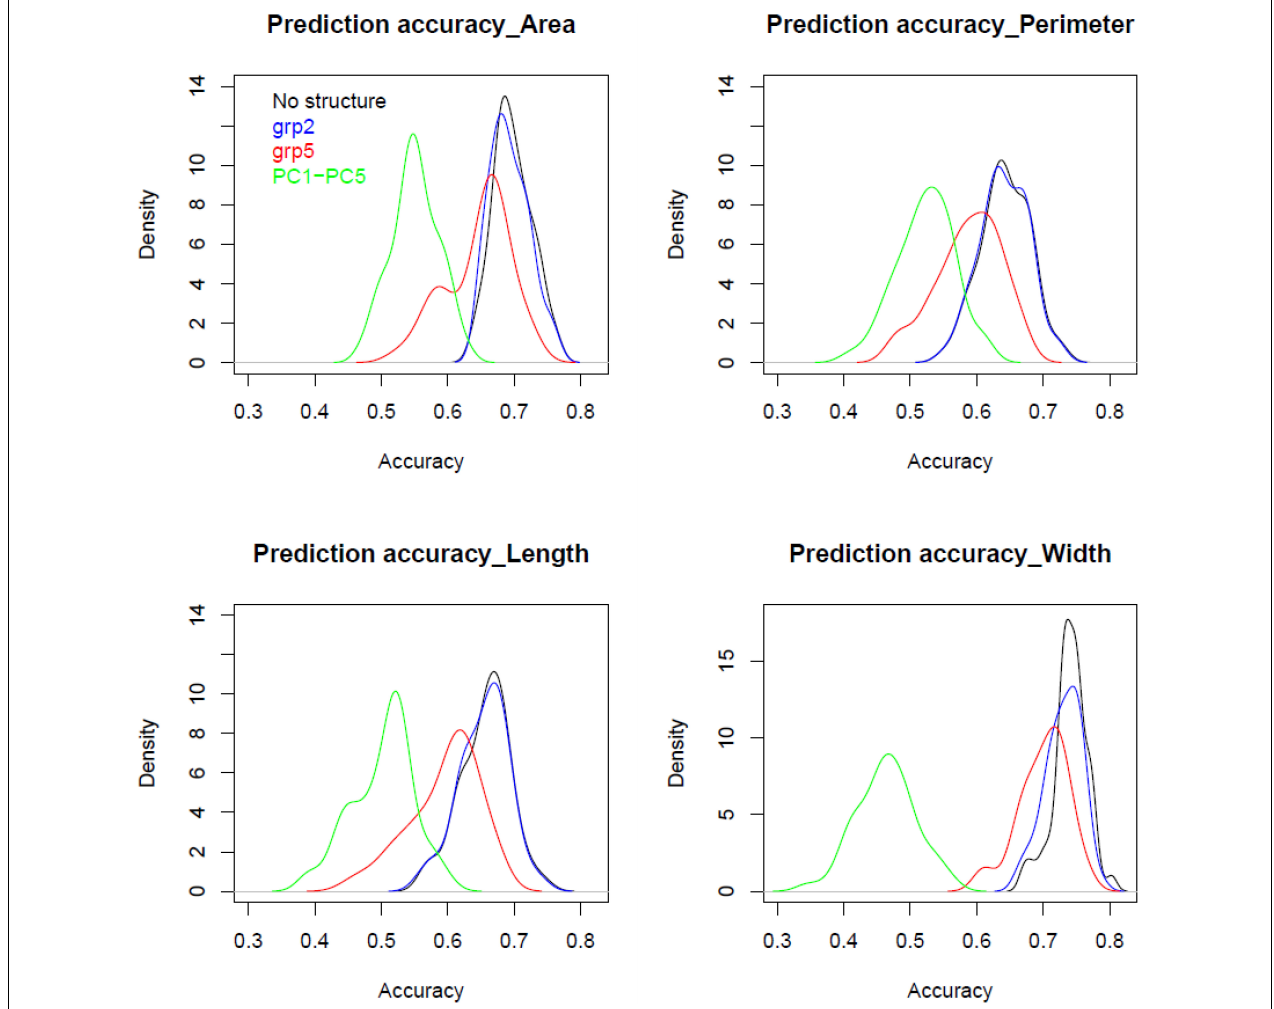
FIGURE 4 | Comparison between densities for prediction accuracy using validation set using different population structure covariates for grain area, perimeter, length, and width of bread wheat